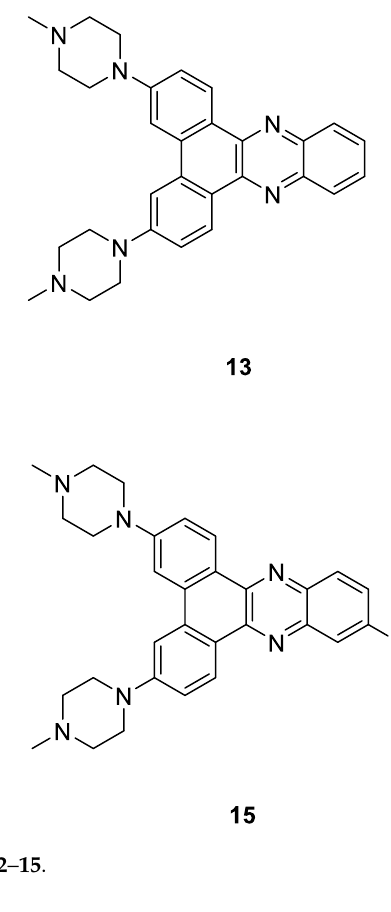
Table 3. Summary of the biological activities of dibenzoquinoxalines 12 – 15